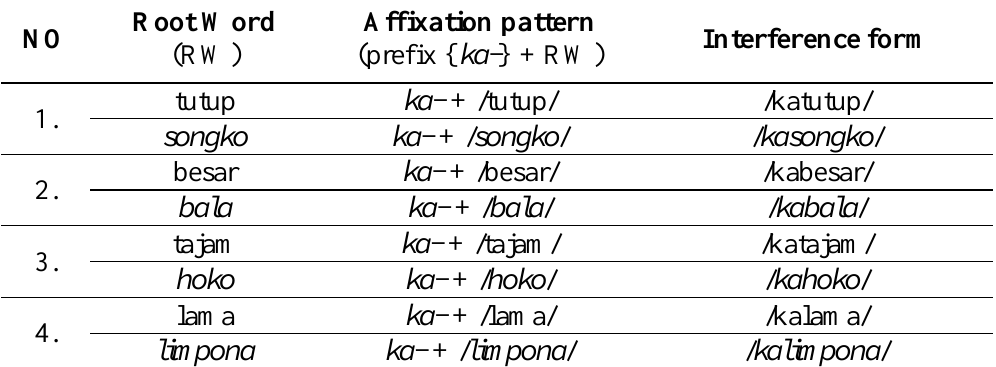
Prefix interference pattern { ka- }